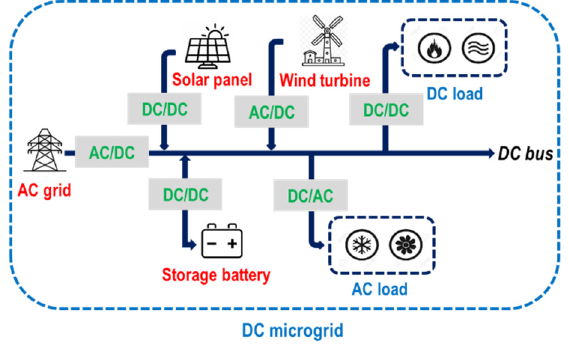
Figure 1. Typical structure of a DC microgrid.